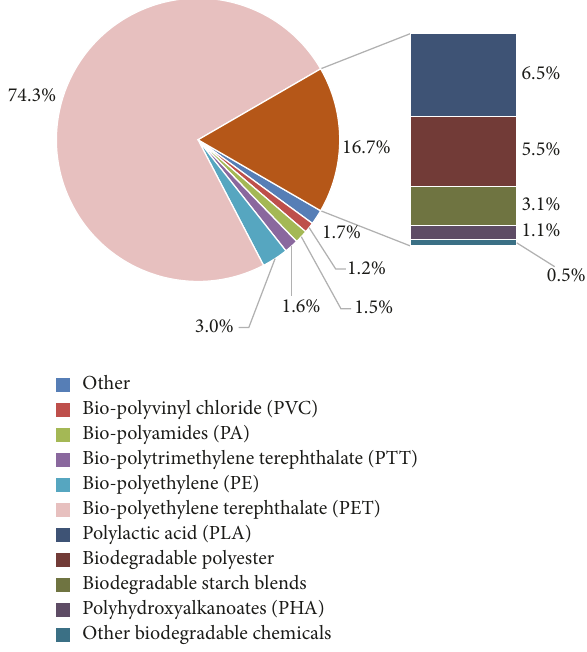
Figure 1: Bioplastics capacity: European